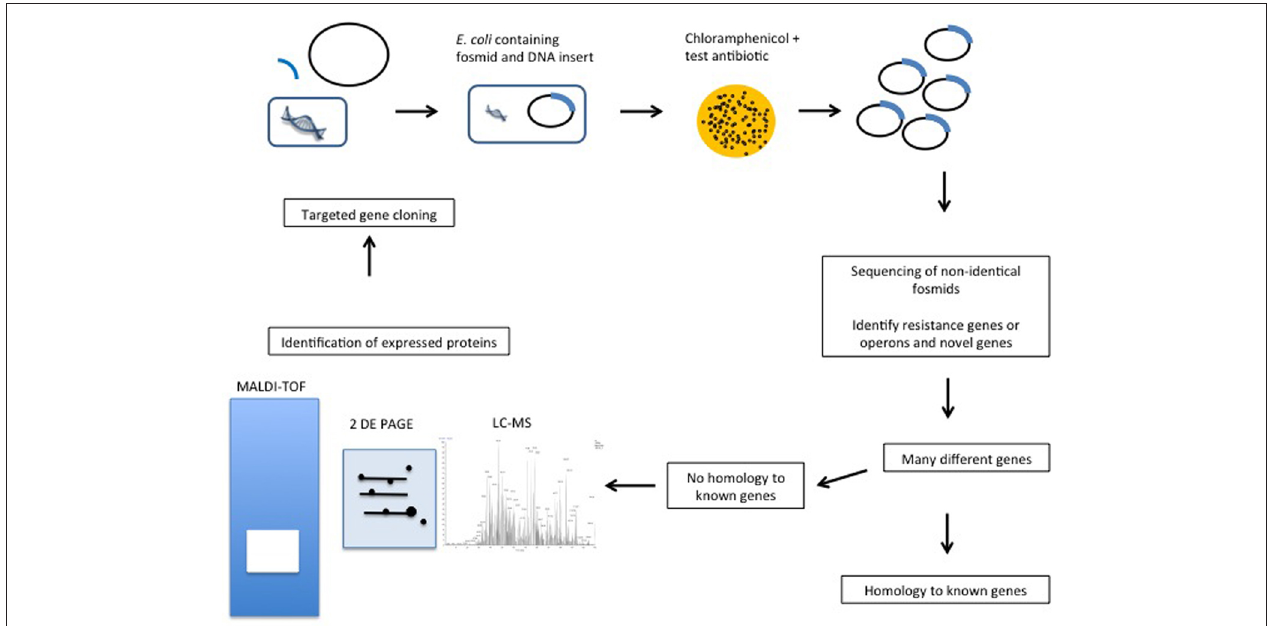
FIGURE 1 | Proposed functional metagenomics and proteomics combined gene function identification